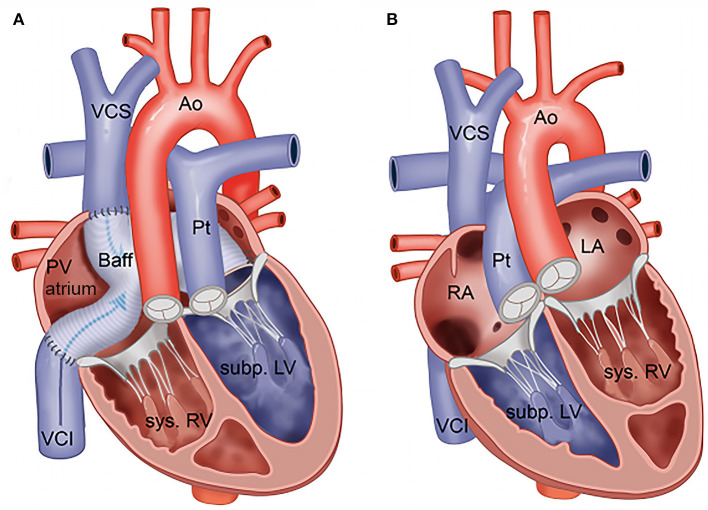
(A) Transposition of the great arteries after Mustard or Senning repair. (B) Congenitally corrected transposition of the great arteries. Ao, aorta; Baff, systemic venous baffle; LA, (morphologically) left atrium; Pt, pulmonary trunk; PV atrium, pulmonary venous atrium; RA, (morphologically) right atrium; Subp. LV, subpulmonary LV; Sys. RV, systemic RV; VCI, inferior vena cava; VCS, superior vena cava.